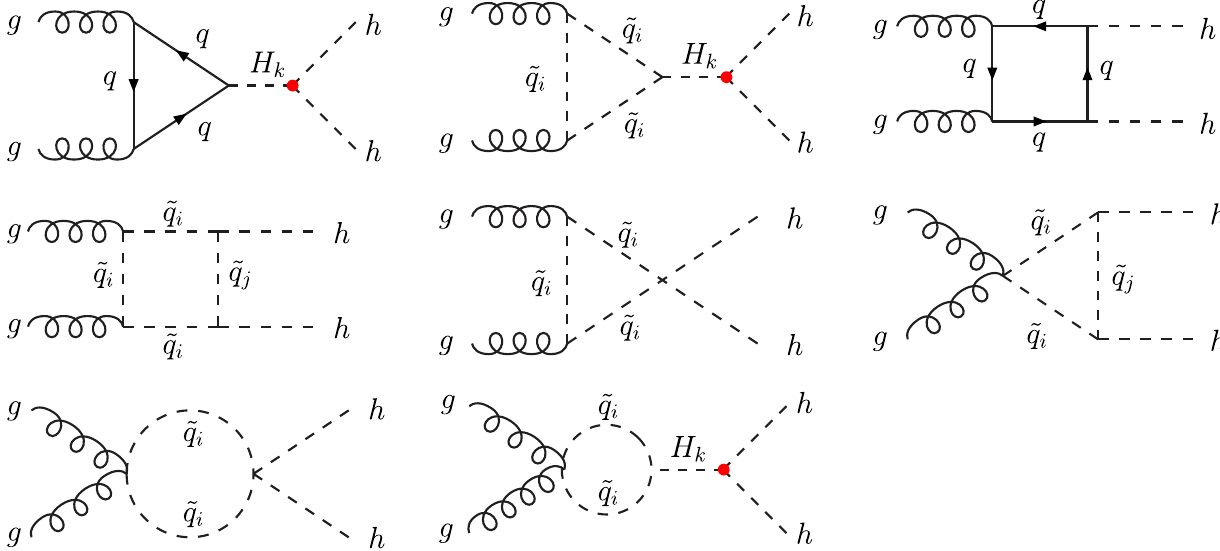
proceed via H k = H 1 , H 2 , H 3 , with one of these being the SM-like h , depending on the parameter choice